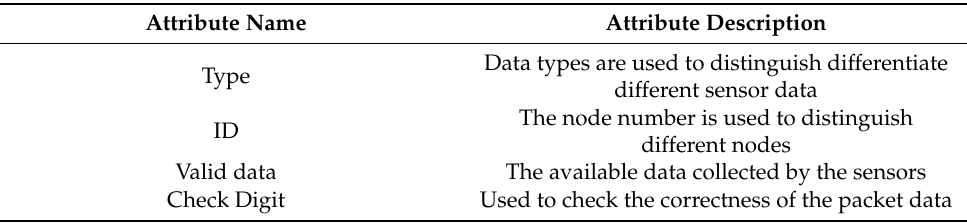
Table 7. The specific meaning of each field of the Bluetooth data